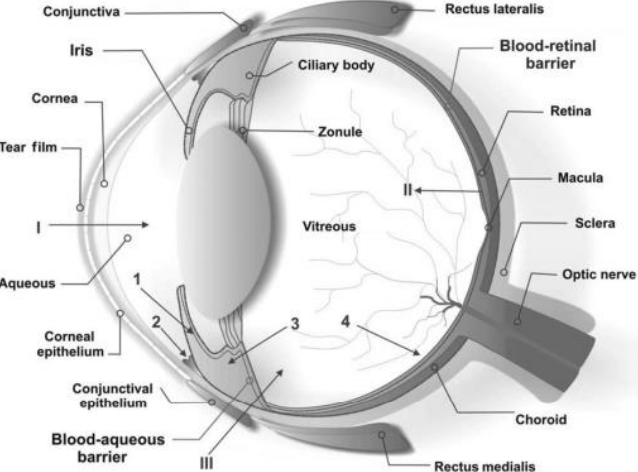
Figure 2. Schematic representation of the various anatomical structures of the eye and the physio- logical protective mechanisms, including tear turnover (tear film), lowly permeable cornea, and the blood retinal barrier. The primary physiologic blockage against instilled ocular drugs is the tear film. Reproduced from [16] with permission of John Wiley and Sons.